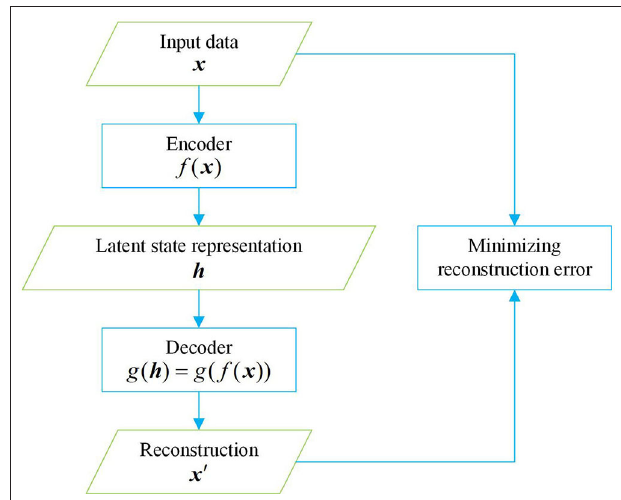
FIGURE 1 | General processing flow of an